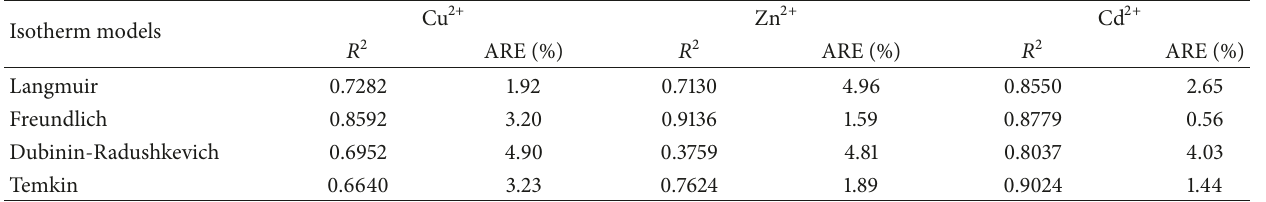
Table 3: The comparison between correlation coefficient, 𝑅 2 , and average relative error (ARE) among seven two-parameter isotherm models. Cu 2+ Zn 2+ Cd 2+ Isotherm models 𝑅 2 ARE (%) 𝑅 2 ARE (%) 𝑅 2 ARE (%) Langmuir